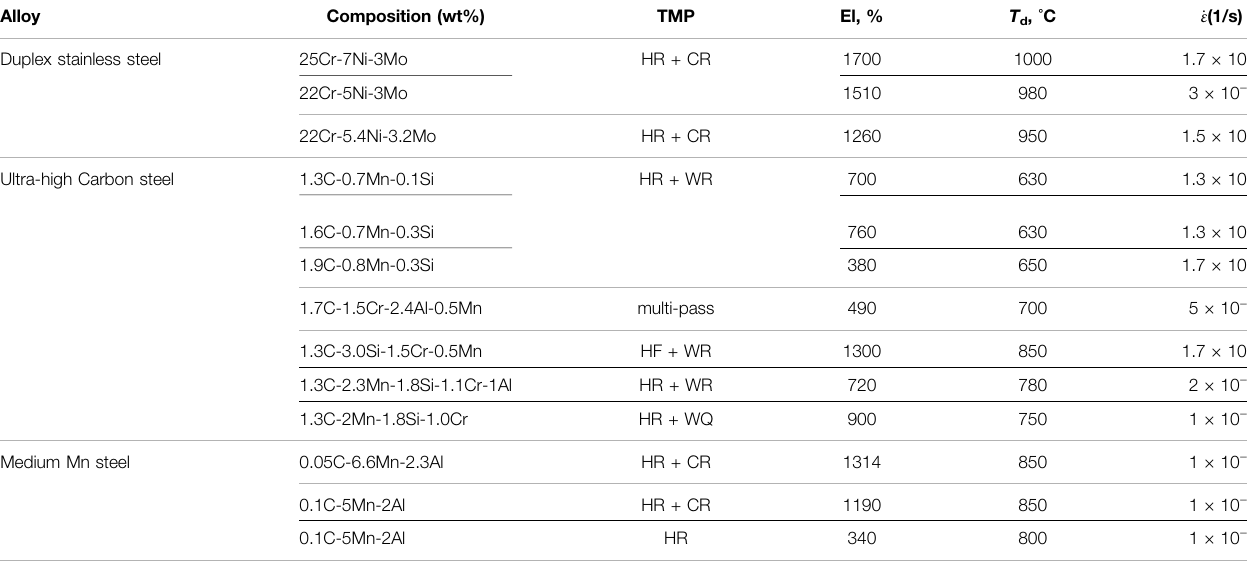
TABLE 3 | Statistic results of chemical composition, thermomechanical processing and total elongation and deformation conditions for various ferrous superplastic alloys (Zhang et al., 2014b; Li et al., 2014; Cao et al., 2017; Han et al., 2017; Cao et al., 2018).